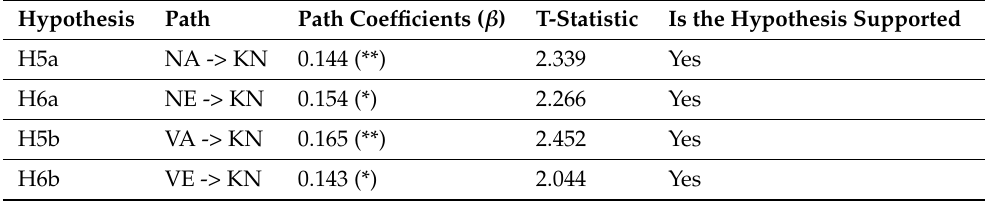
Table 6. Hypothesis testing of mediating variables on COVID-19